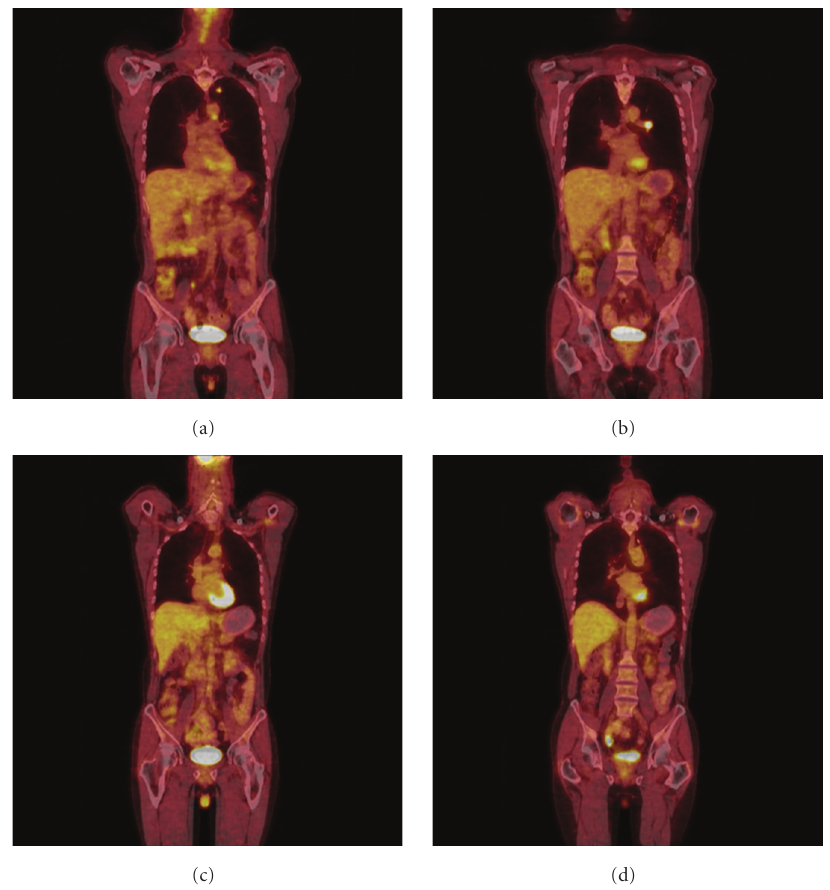
Figure 2: Coronal views of FDG-PET/CT scan obtained before (a)-(b) and after (c)-(d) treatment for primary NSCLC in patient with synchronous SBM. At diagnosis, the patient demonstrated hypermetabolic activity in a primary LUL tumor with mediastinal (a) and hilar (b)lymphadenopathy. Two years after treatment, including surgical resection, chemotherapy, and mediastinal RT, there is no evidence of hypermetabolic activity at the prior sites of thoracic involvement